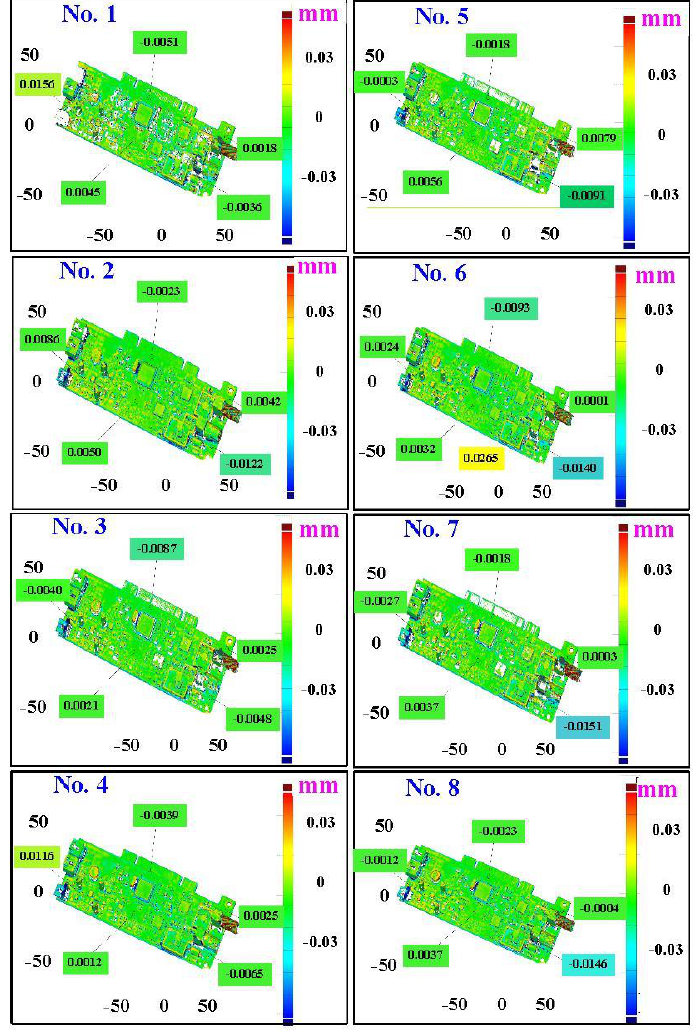
Figure 18. CAV results of the circuit board.